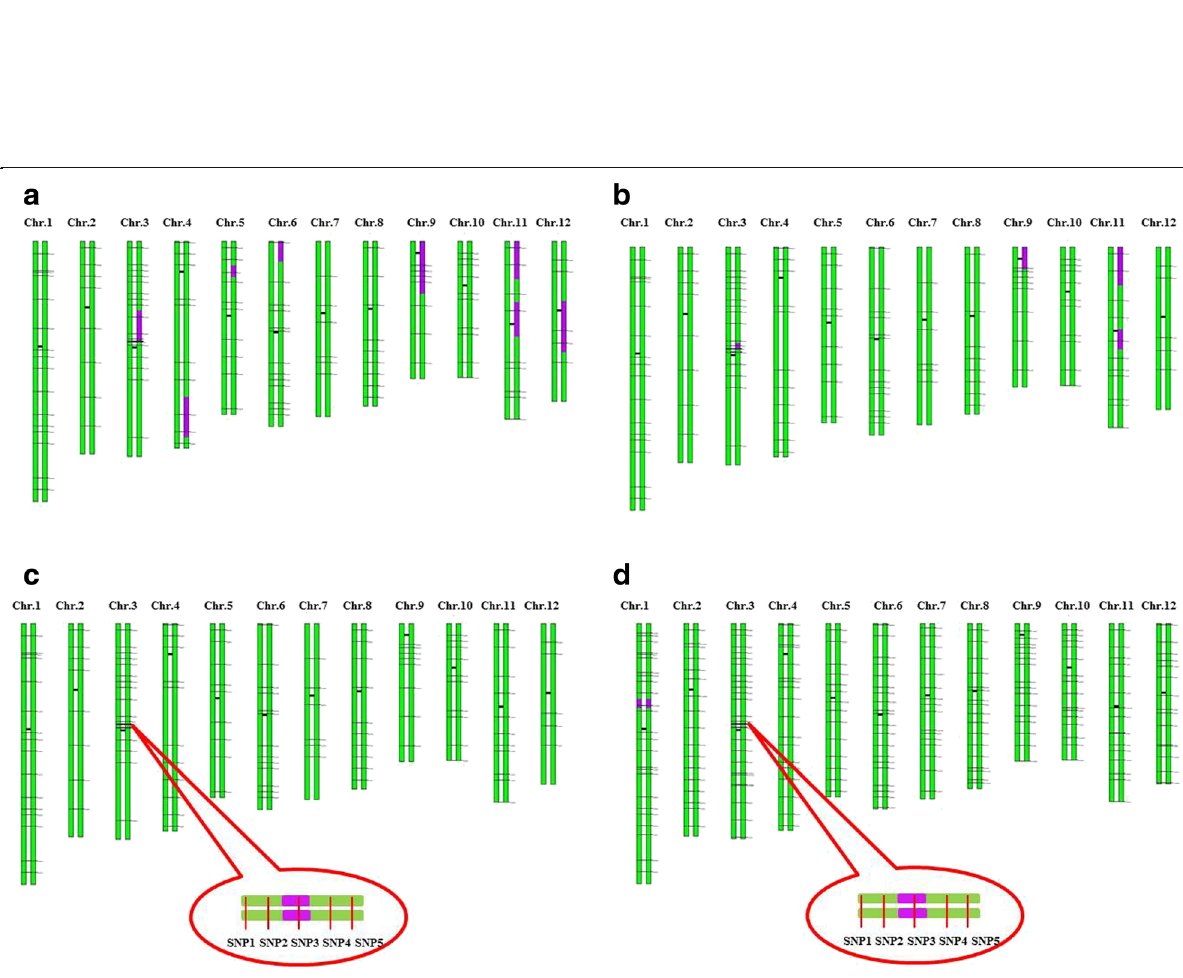
Fig. 3 Graphical Genotype (GGT) of selected individuals or lines. a GGT of the first selected individual BC3F1 – 1 had recombination between SNP3 and SNP5. b GGT of the selected individual BC3F2 – 2 had recombination between SNP3 and SNP4. c GGT of the selected individual BC3F3 – 3 with recombination between SNP3 and SNP2. d GGT of the improved line BC3F4 – 4 with the highest genetic background recovery ratio. The green type means the chromosomes of Kongyu 131, and the purple represents the fragments from GKBR, the horizontal black lines indicate the physical position of SNP